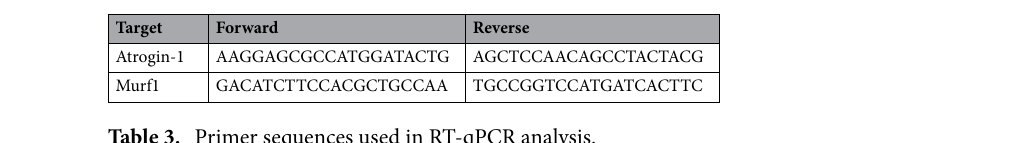
Table 3. Primer sequences used in RT-qPCR